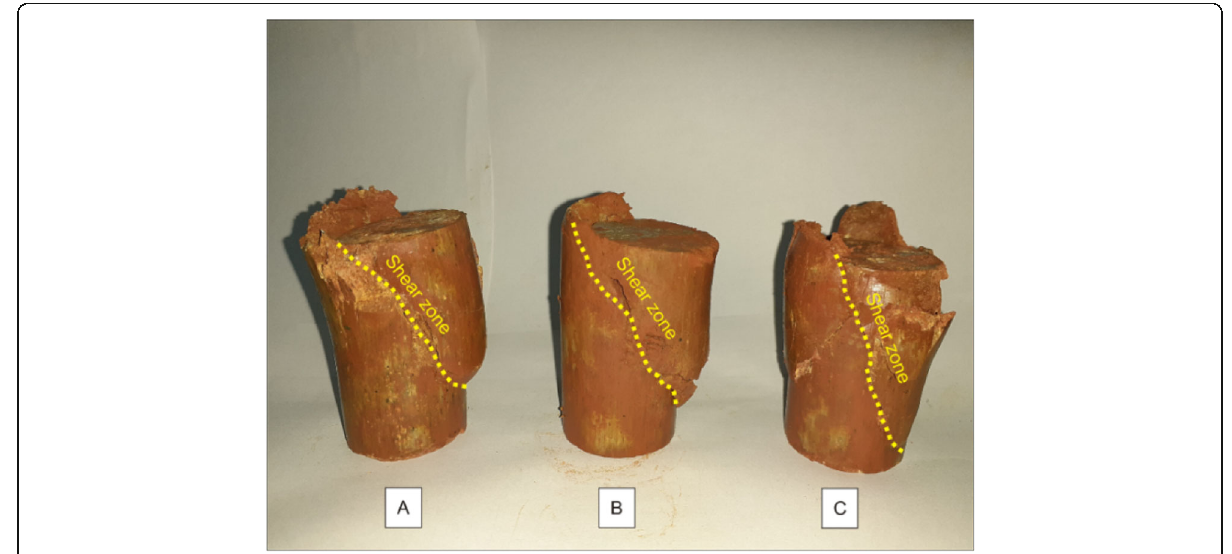
Fig. 11 The results of a triaxial test for high clay layers. Note: σ 1 = 98.0665 kN.m − 2 ( a ); σ 2 = 137.293 kN.m − 2 ( b ); σ 3 = 176.52 kN.m − 2 ( c